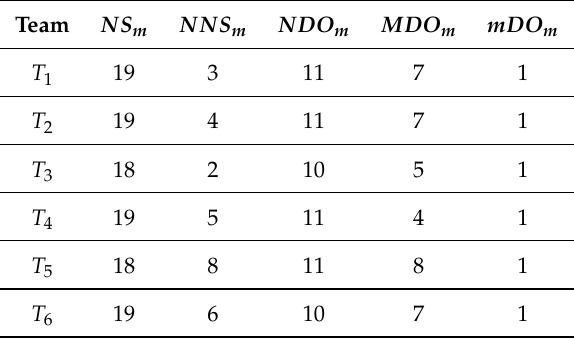
Table 7. Detailed analysis of the optimized physician schedule for